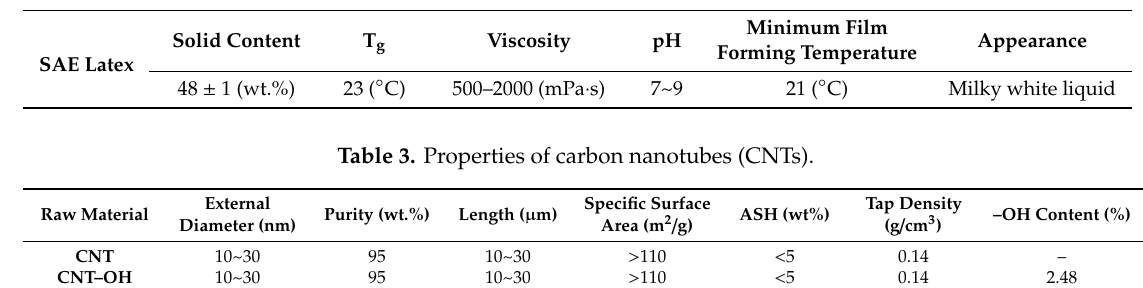
Table 2. Physicochemical characteristics of the SAE latex.